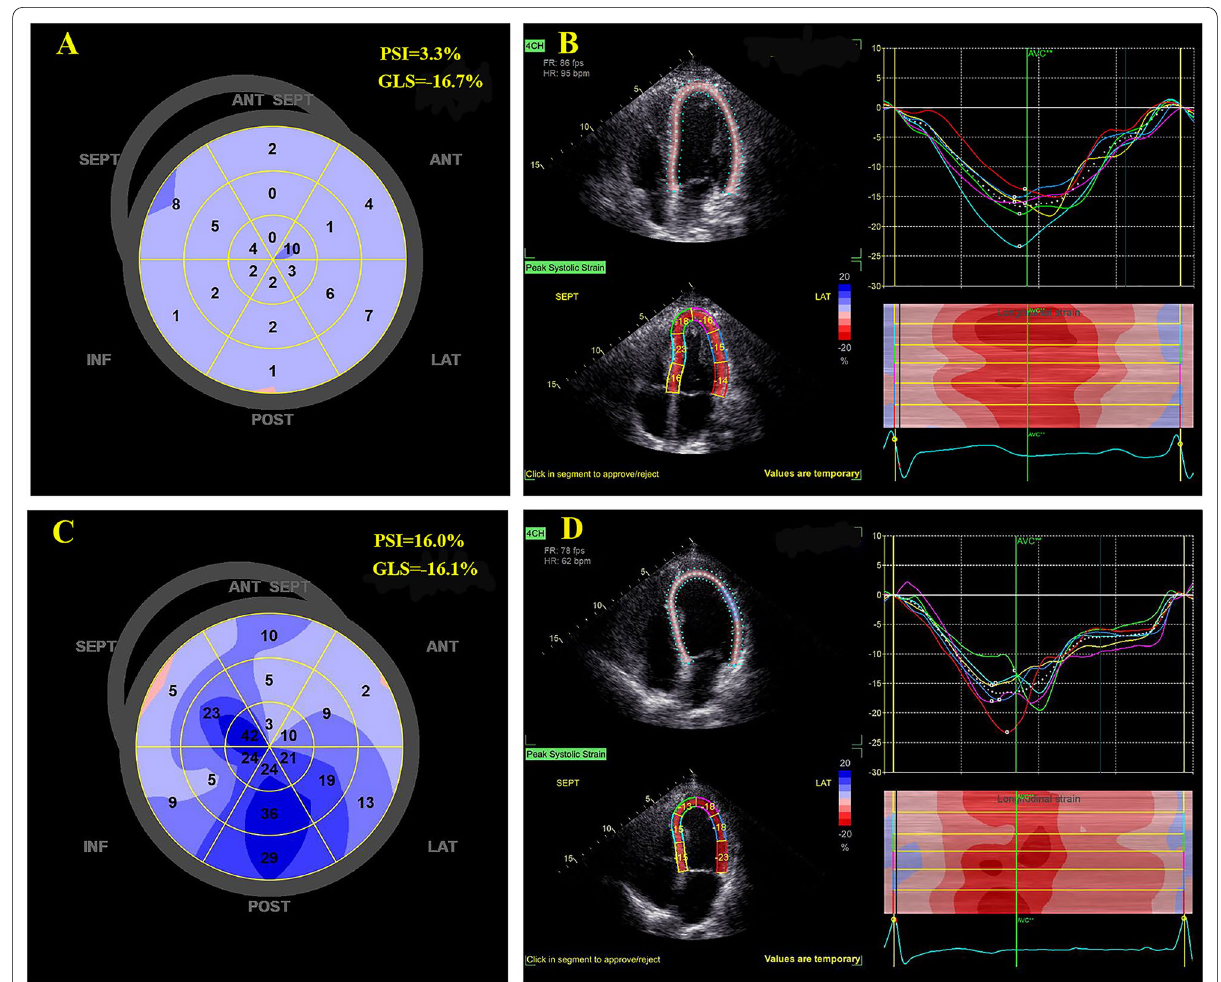
Fig. 1 Representative cases. The bull’s eye map of post-systolic index (PSI) and longitudinal strain curves of six myocardial segments in the apical four-chamber view of the patients without ( A , B ) and with ( C , D ) major adverse cardiovascular events during follow-up. Both patients showed normal global longitudinal strain (GLS) and left ventricular ejection fraction (LVEF). A Normal bull’s eye map of PSI with an average value of 3.3%. B Normal strain curves with little or no sign of post-systolic shortening (PSS). C Abnormal bull’s eye map of PSI with an increased average value of 16.0%. D Abnormal strain curves where the green segment exhibits obvious